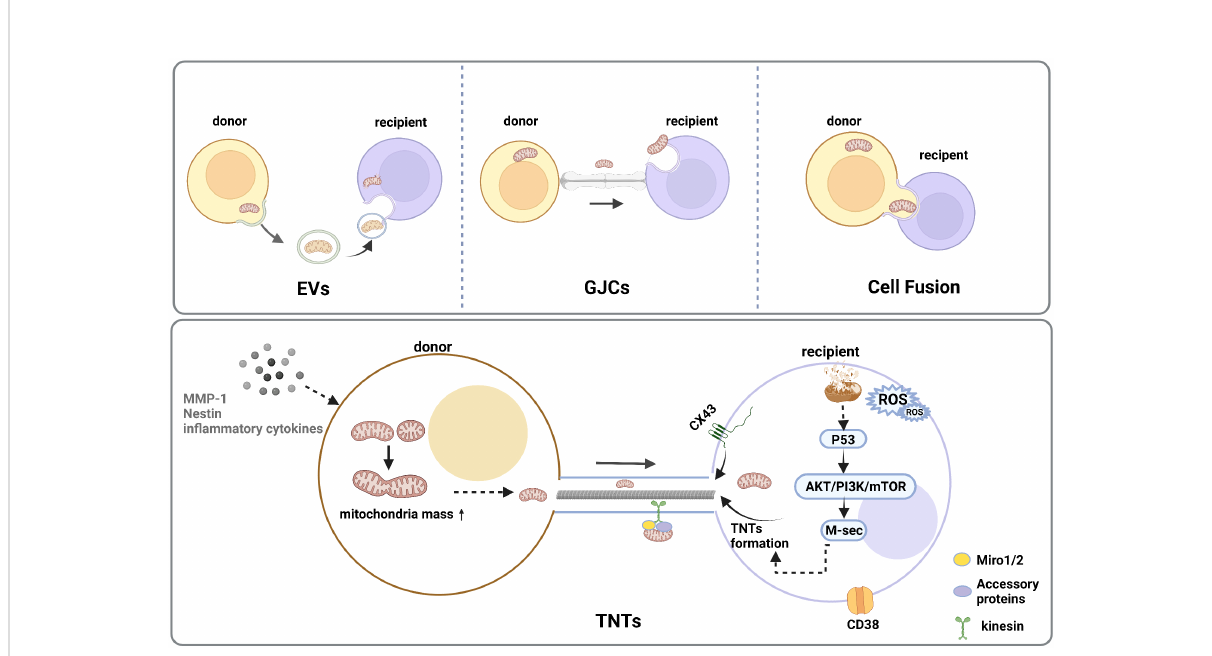
FIGURE 2 Intercellular mitochondrial transfer modes. There are four major transfer modes, such as extracellular vehicles (EVs), cell fusion, gap junction connections (GJCs), tunneling nanotube (TNTs)under the stimulation of stress reaction, in fl ammation response, DNA damage, and increased interstitial ROS levels. TNTs are the common type of cellular community which could transform the metabolism and functional features of the recipient cells, and the initial increase in mitochondrial mass could reveal between the donor and recipient cells. A high level of ROS in mitochondrial recipient cells can trigger activation of p53 and the downstream Akt/PI3K/mTOR axis, resulting in an overexpression of M-sec, which could enhance TNT